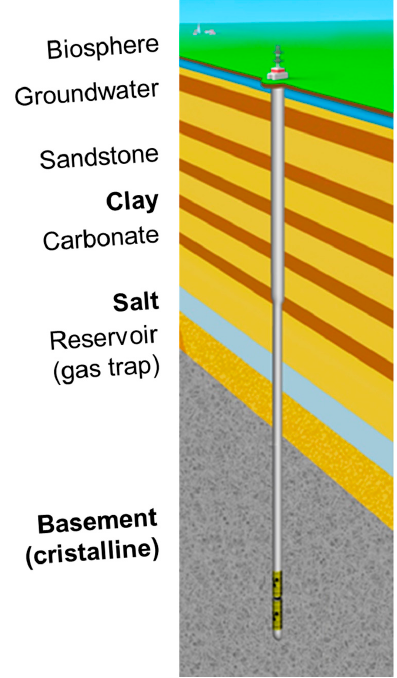
Figure 1. Concept for borehole disposal in deep geological formations (example).